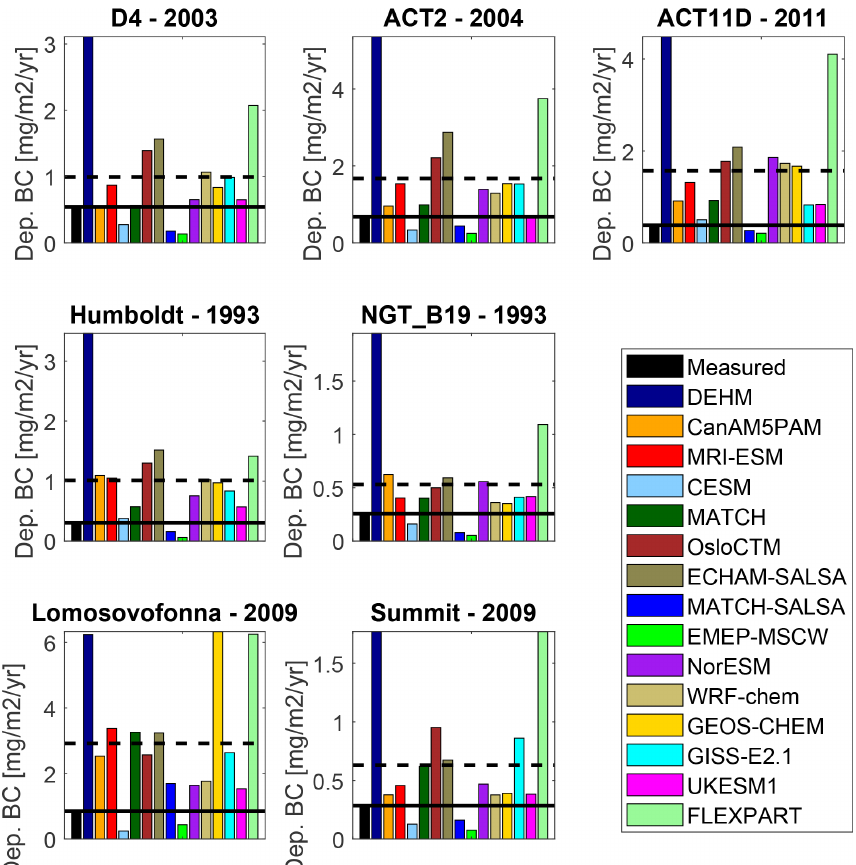
Figure 14. Annual average BC deposition flux values for the seven ice core locations (Fig. 1b) for each model based on values from 2008– 2009 and 2014–2015. The observed fluxes are plotted in black, and a black line indicates the level of the average observed flux; the black dashed line is the model mean for each location. The period used for plotting is based on all available years after 1990; the title indicates the last available year form the ice core